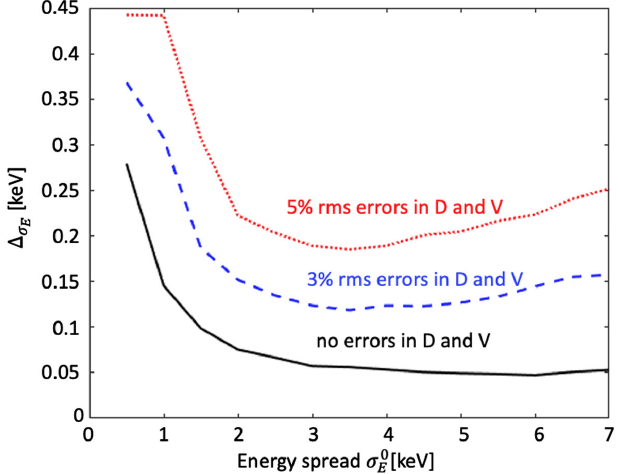
FIG. 4. The impact of instrumental errors in setup of voltage and dispersion on the reconstruction error from dispersion scan